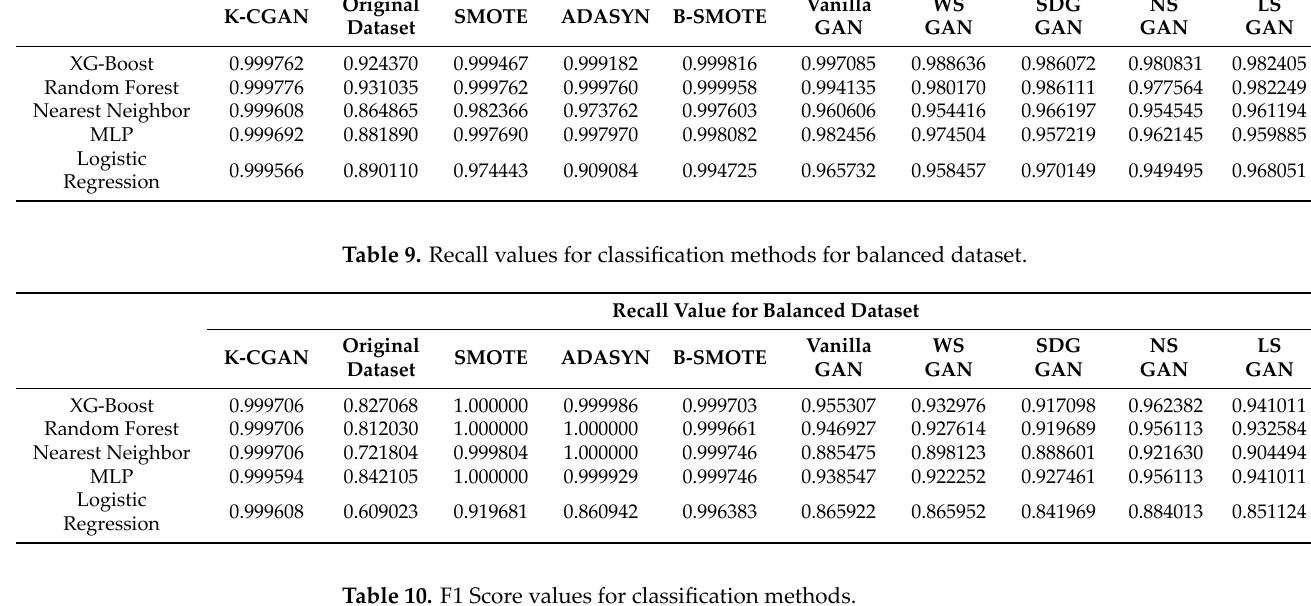
Table 8. Precision values for classification methods for balanced dataset. Precision Value for Balanced Dataset